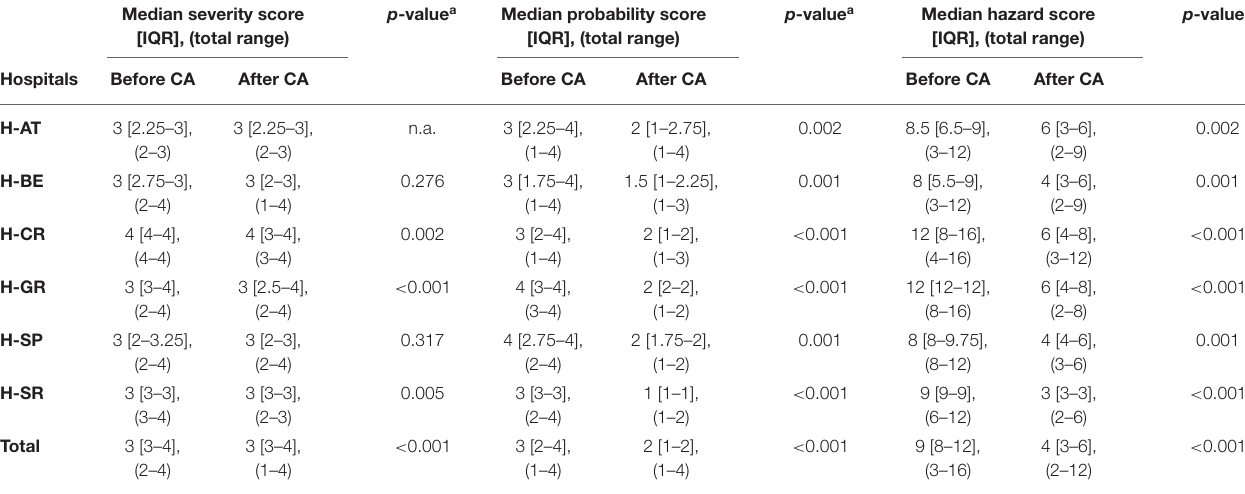
TABLE 3 | Failure mode quantification: severity, probability, and hazard scores before and after corrective actions. p -value a Median probability score p -value a Median hazard score Median severity score [IQR], (total range) [IQR], (total range) [IQR], (total